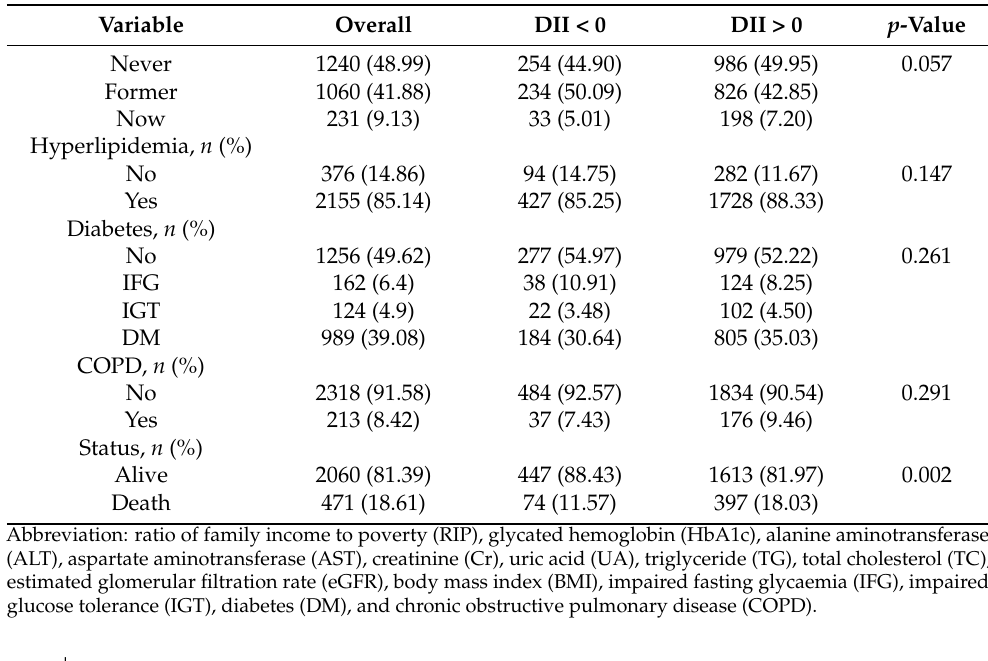
Figure 1. Flow diagram for inclusion of the study population.